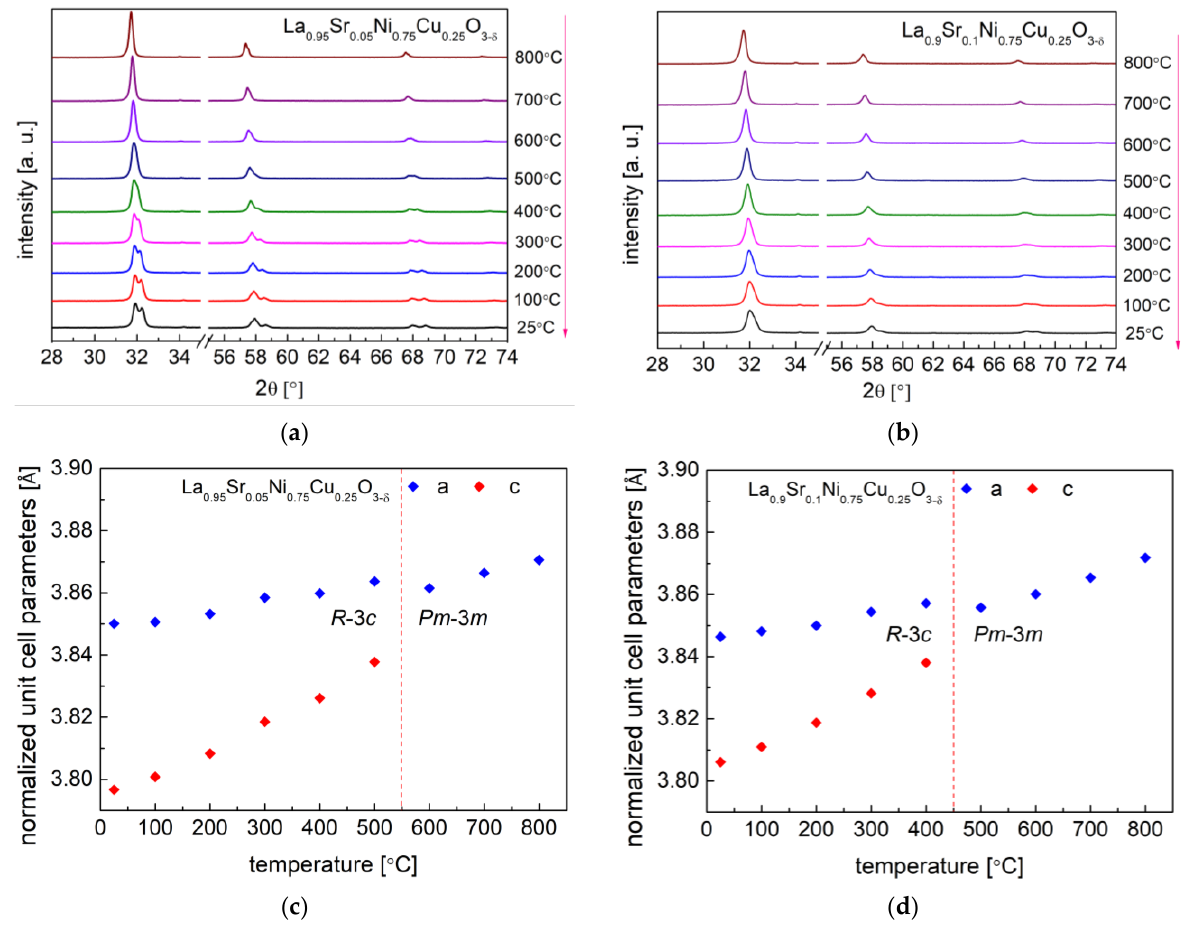
Figure 4. HT-XRD diffractograms recorded during the cooling from 800 °C to 25 °C in air for: ( a ) La 0.95 Sr 0.05 Ni 0.75 Cu 0.25 O 3−δ and ( b ) La 0.9 Sr 0.1 Ni 0.75 Cu 0.25 O 3−δ ; Normalized unit cell parameters dependence on temperature for ( c ) La 0.95 Sr 0.05 Ni 0.75 Cu 0.25 O 3−δ and ( d ) La 0.9 Sr 0.1 Ni 0.75 Cu 0.25 O 3−δ .